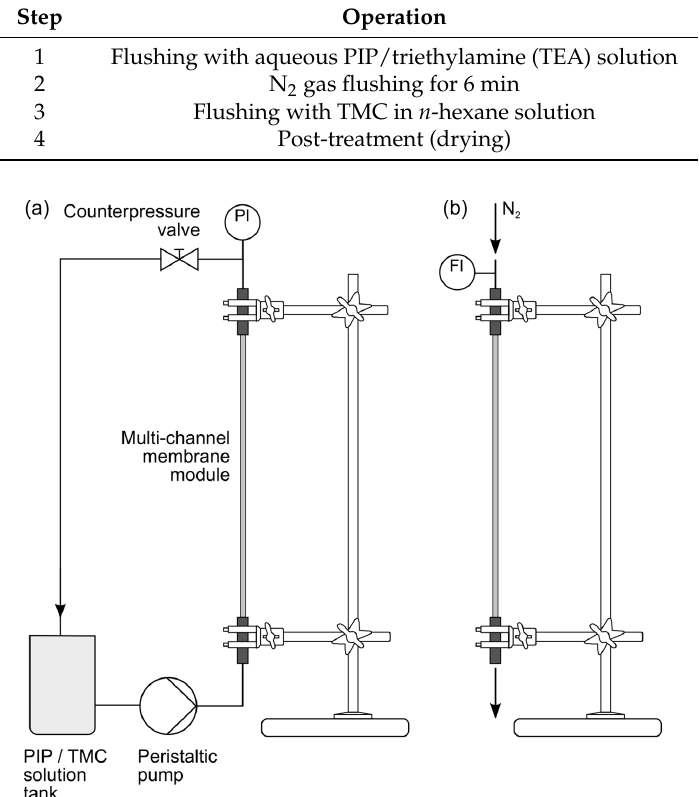
Table 2. Preparation procedure of composite multi-channel capillary membranes (MCM).